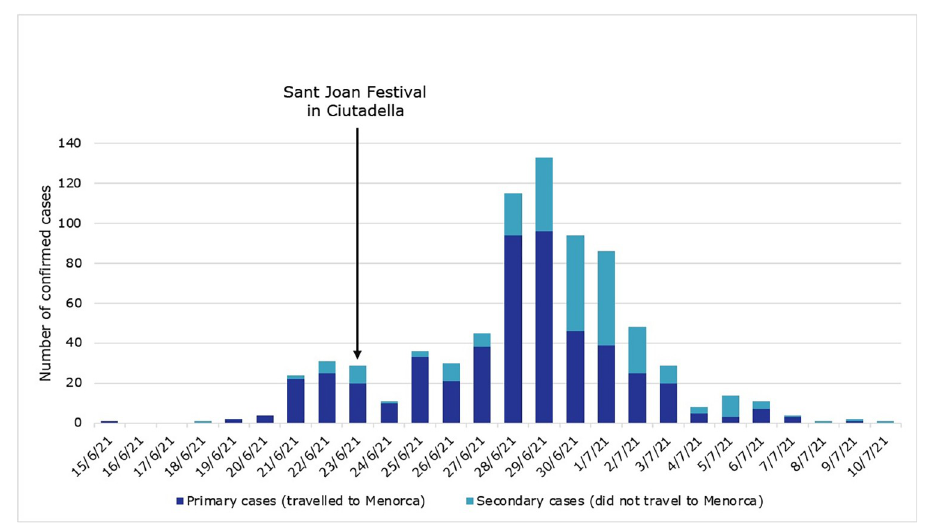
Fig 3. Epidemic curve of the Menorca trip outbreak of SARS-CoV-2, Catalonia, June and July of 2021 (n = 760).